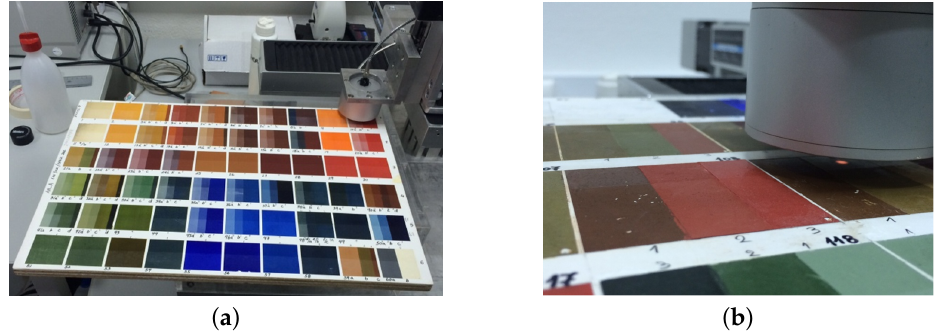
Figure 2. ( a ) Measurement of the egg tempera color panel and ( b ) a close-up of the measurement.